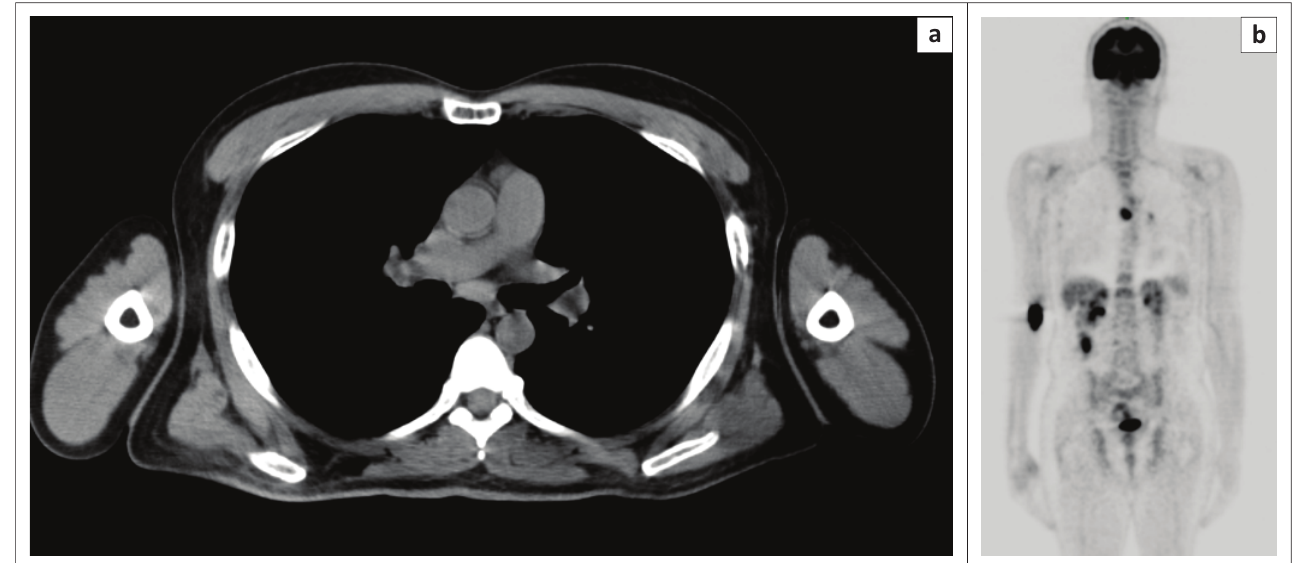
FIGURE 1: (a) Chest computed tomography (CT) and (b) positron emission tomography (PET) scan showing sub-carinal lymphadenopathy at the start of chemotherapy.